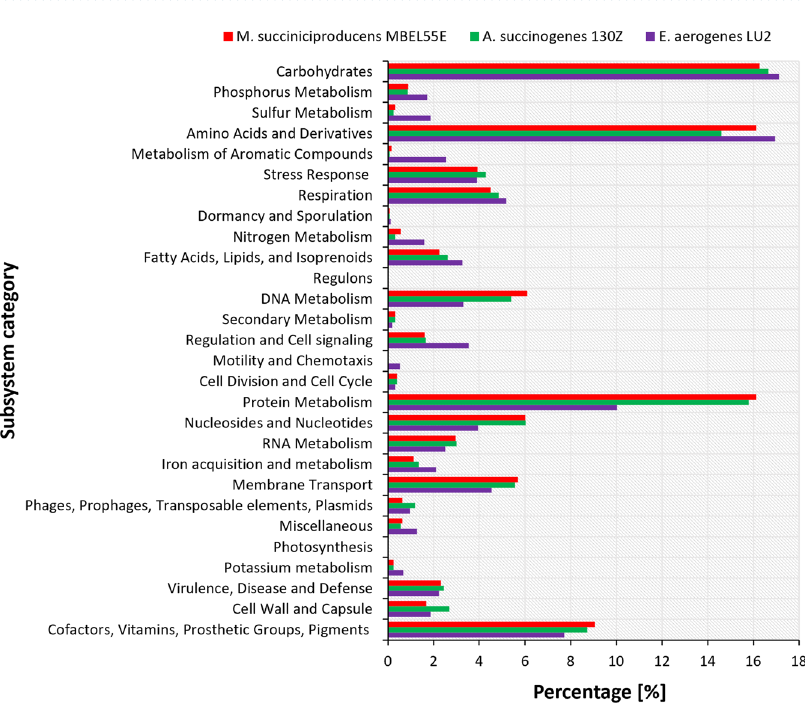
Figure 6. Comparison of subsystem features between Enterobacter aerogenes LU2, Mannheimia succiniciproducens MBEL55E and Actinobacillus succinogenes 130Z strains. Colored bars indicate the number of genes assigned to each subsystem